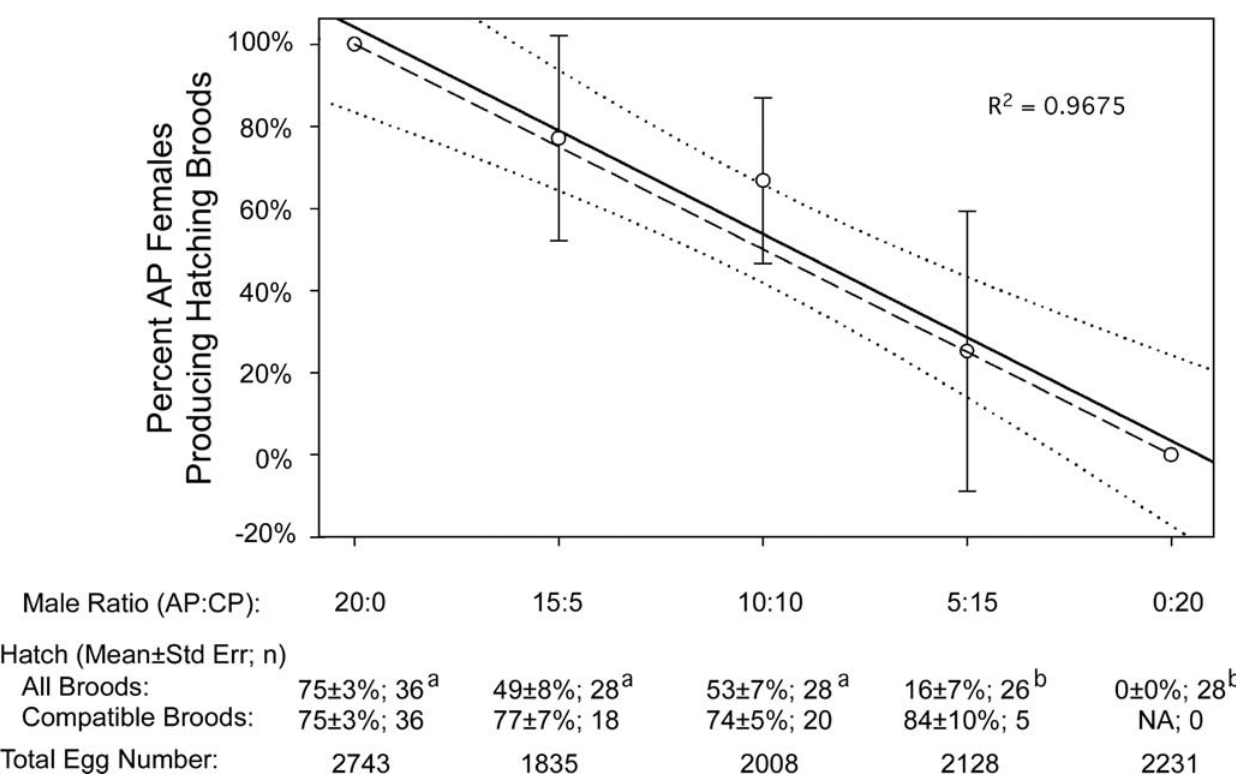
Figure 3. A.polynesiensis suppression strategy and CP male competitiveness. Based upon the observed egg hatch rate, females are scored as either ‘compatible mating’ (=eggs hatching) or ‘incompatible mating’ (=eggs not hatching). The percent compatible females (compatible females/total females) is determined for each cage replicate (10 females/cage; 5 cage replicates/treatment). Circles and bars indicate the mean 6 standard deviation for each treatment (i.e., male ratio). The trend line (solid line) with 95% confidence intervals (dotted lines) are generated based upon the observed values. Predicted values (dashed line) are calculated assuming equal competitiveness of CP and AP males. Below the graph, egg hatch rates are based upon the combined oviposition of females within cages. Differing superscripted letters indicate significant differences (Two-tailed, Mann-Whitney, P , 0.01, Bonferroni corrected). R 2 value is shown for the trend line fitted to observations.